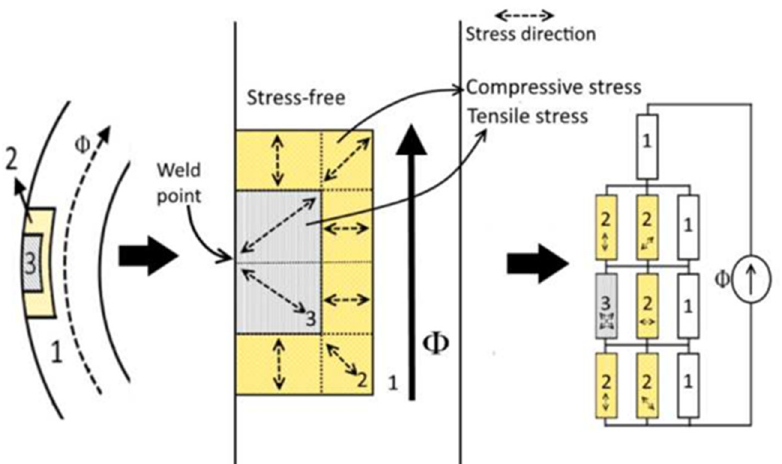
Figure 3. MEC model for a ring core with one weld seam where the flux perpendicular to the cross- section travels through parallel branches of healthy, degraded and welded material. The indices of the reluctances indicate different stress-dependent material properties corresponding to the regions described in Figure 2.